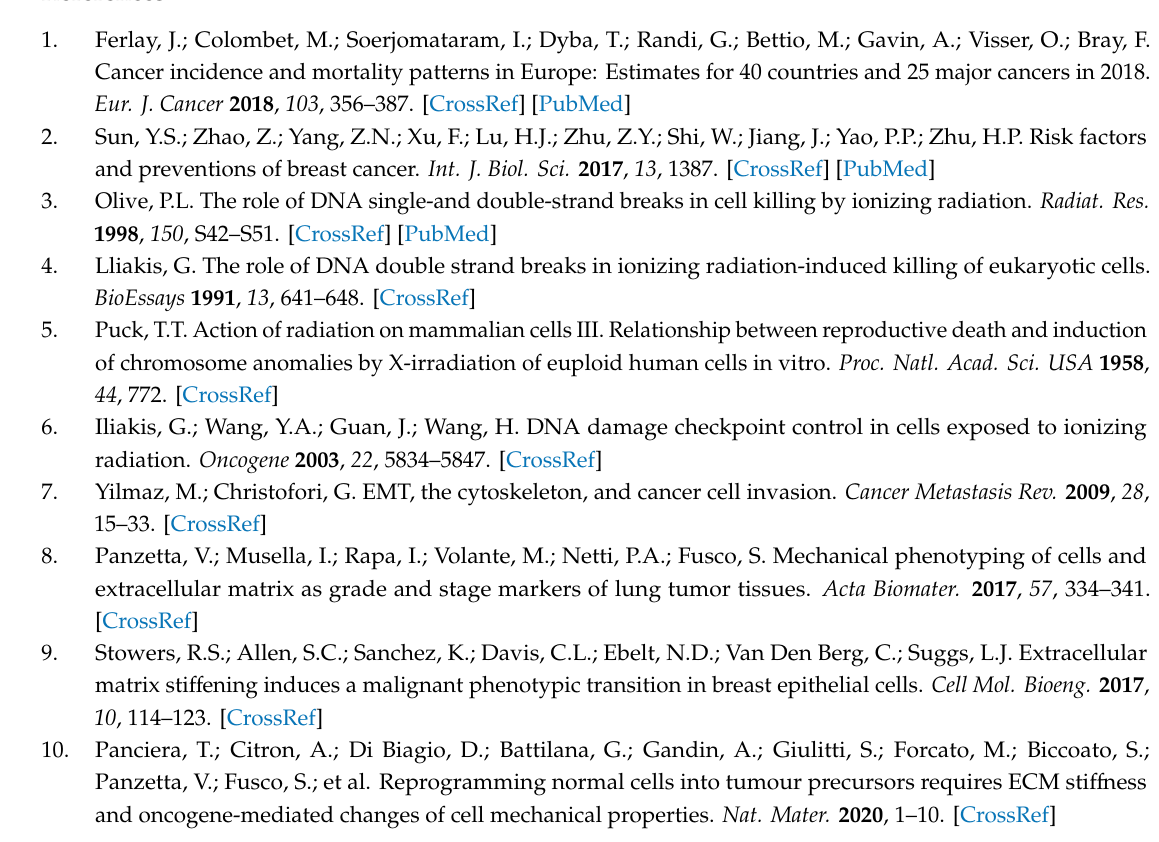
Figure S1: Zoomed pictures of spreading of MCF10A and MDA-MB-231 cells, Figure S2: Percentage distribution of cell spreading area of MCF10A cells before and after RT, Figure S3: Percentage distribution of cell spreading area of MDA-MB-231 cells before and after